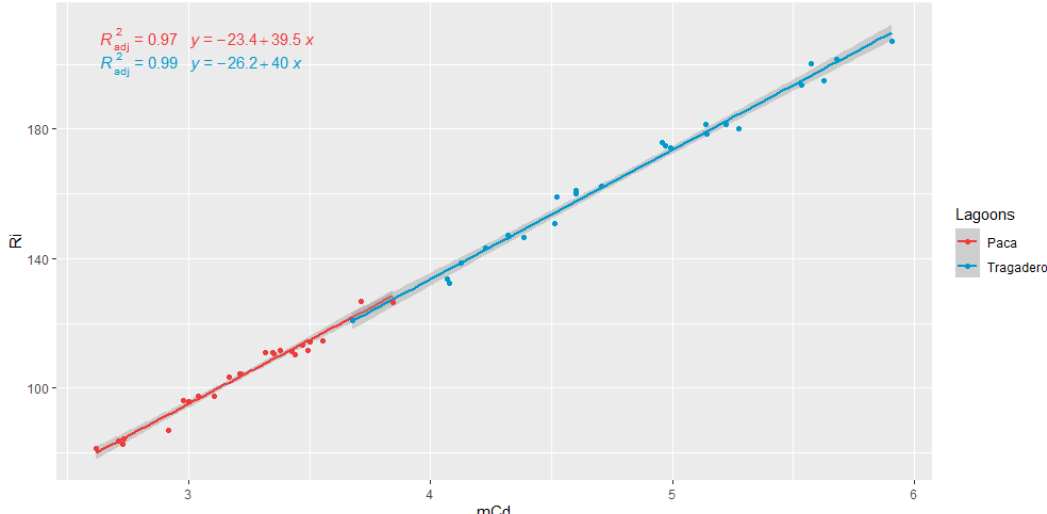
Figure 5. Linear regression between modified degree of contamination (mCd) and potential ecological risk (Ri) values of the lagoons.